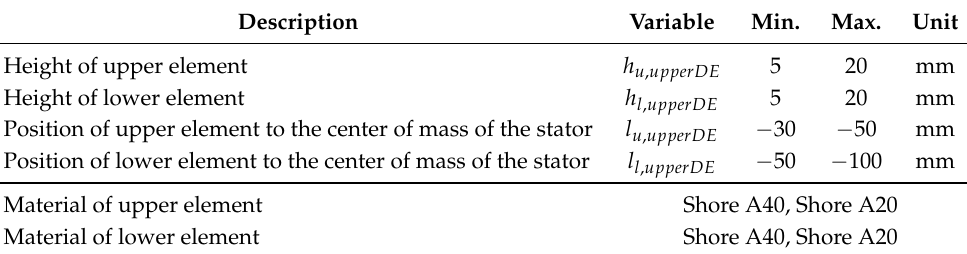
Table 2. Variables for